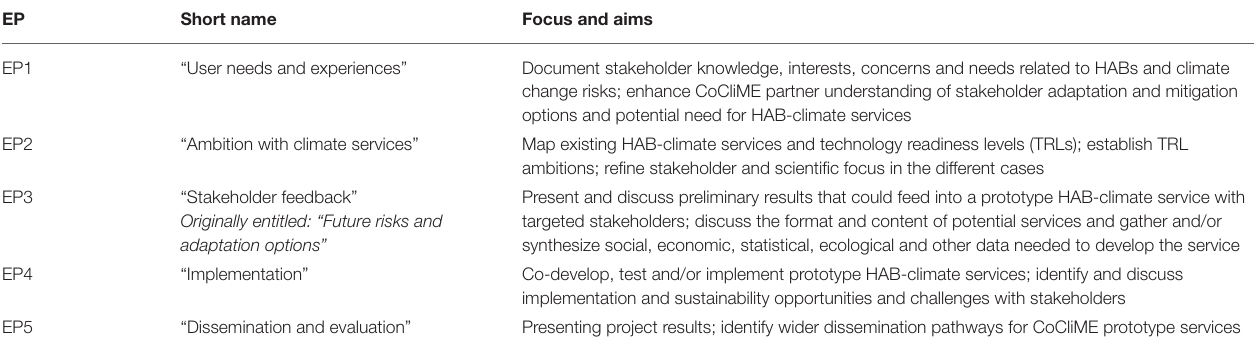
TABLE 2 | Focus and aims of the project-wide Engagement Points